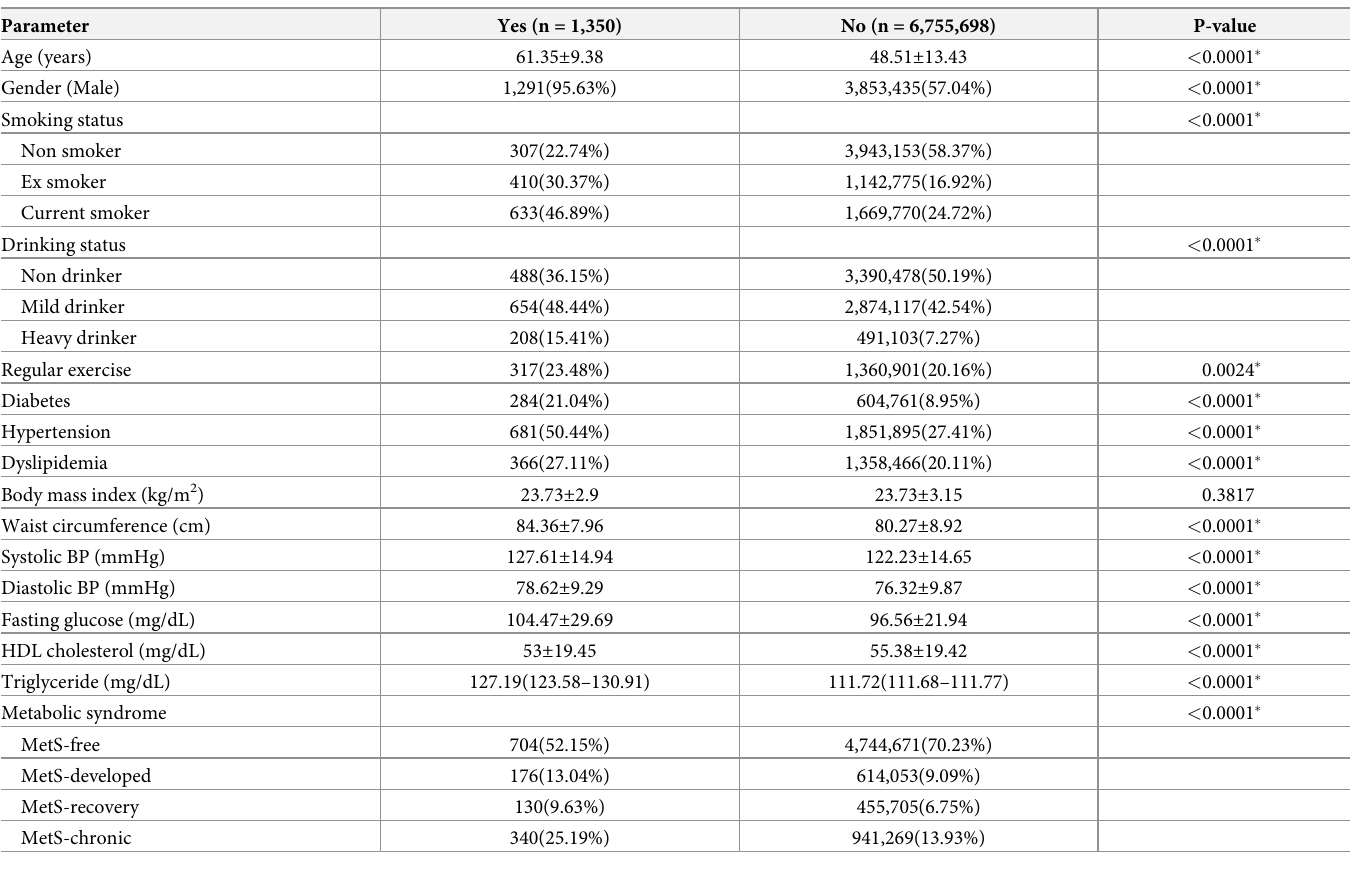
Table 1. Analysis of factors potentially associated with laryngeal cancer (n =